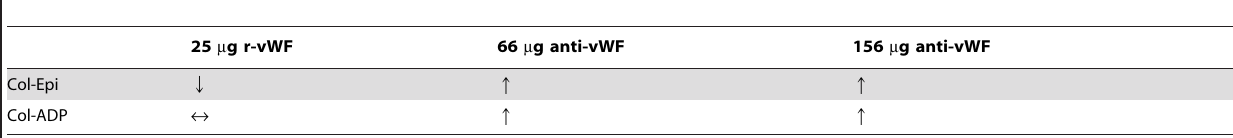
Table 4. Effect of vWF levels on primary hemostasis in thrombocytopenic patients with cirrhosis.